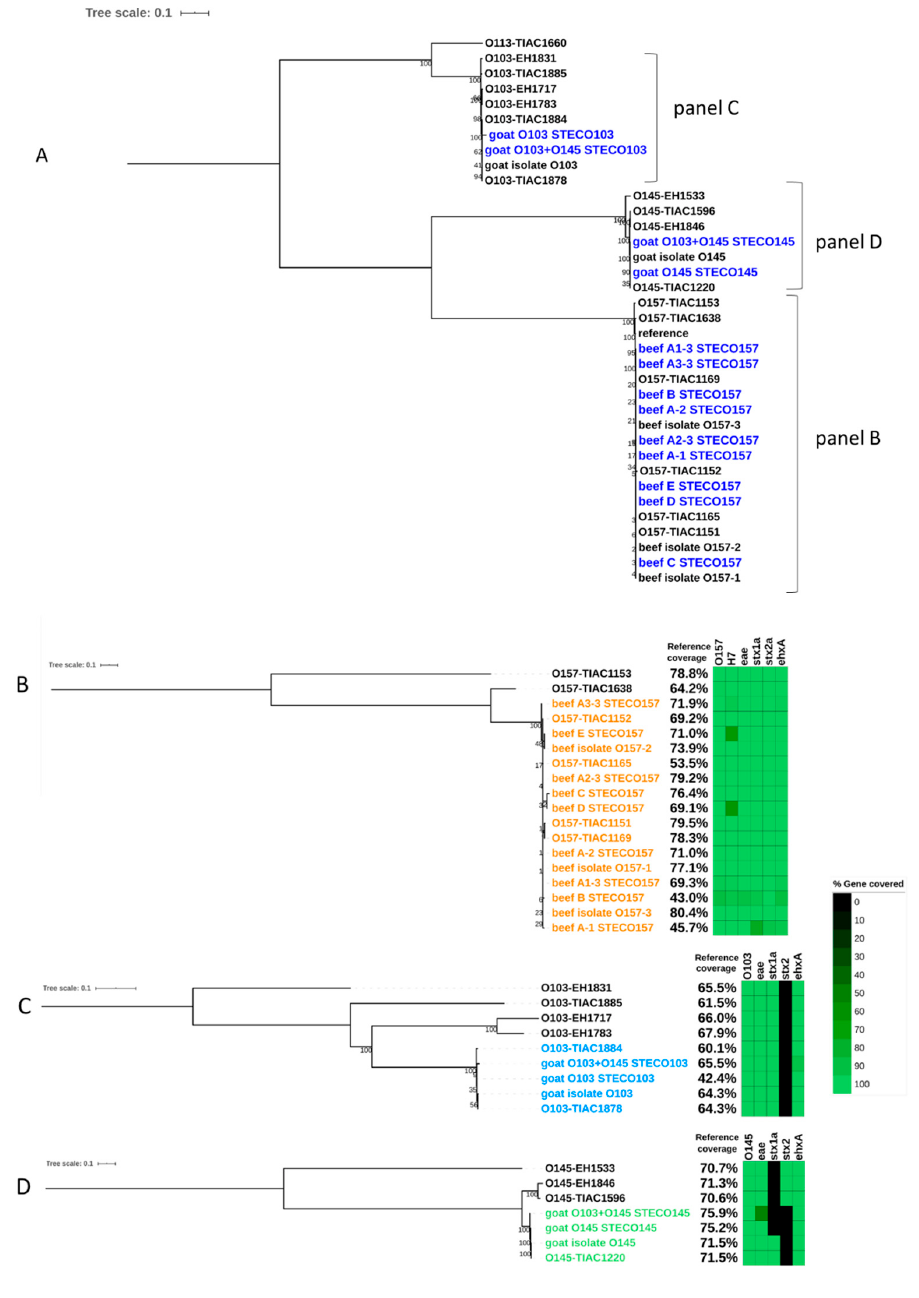
Figure 5. (A ) SNP-based phylogenetic tree of STEC strains inferred from metagenomics samples (dark blue) and of sequenced isolates (black). Reference: E. coli O157:H7 str. Sakai (BA000007.2). Beef/goat isolate: STEC isolate obtained after following the conventional method on the prepared spiked samples. ( B ) Phylogenetic tree of the STEC O157 with percentage of the reference genome covered and gene detection in the strains. Orange: closely related strains from the outbreak cluster. ( C ) Phylogenetic tree of the STEC O103 with percentage of the reference genome covered and gene detection in the strains. Blue: closely related strains. ( D ) Phylogenetic tree of the STEC O145 with percentage of the reference genome covered and gene detection in the strains. Green: closely related strains. The scale bar represents nucleotide substitution per 100 nucleotide site. Node values represent bootstrap support values.